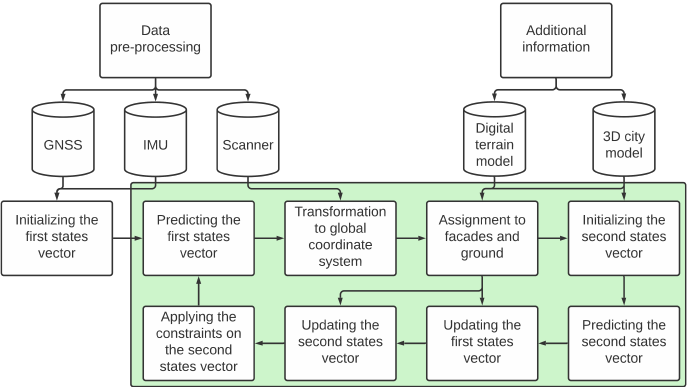
Figure 5. Sketch of the DSIEKF workflow in the context of the current paper. Steps within the green area are applied in each epoch. the GNSS and IMU are only used for the initialization step in the current